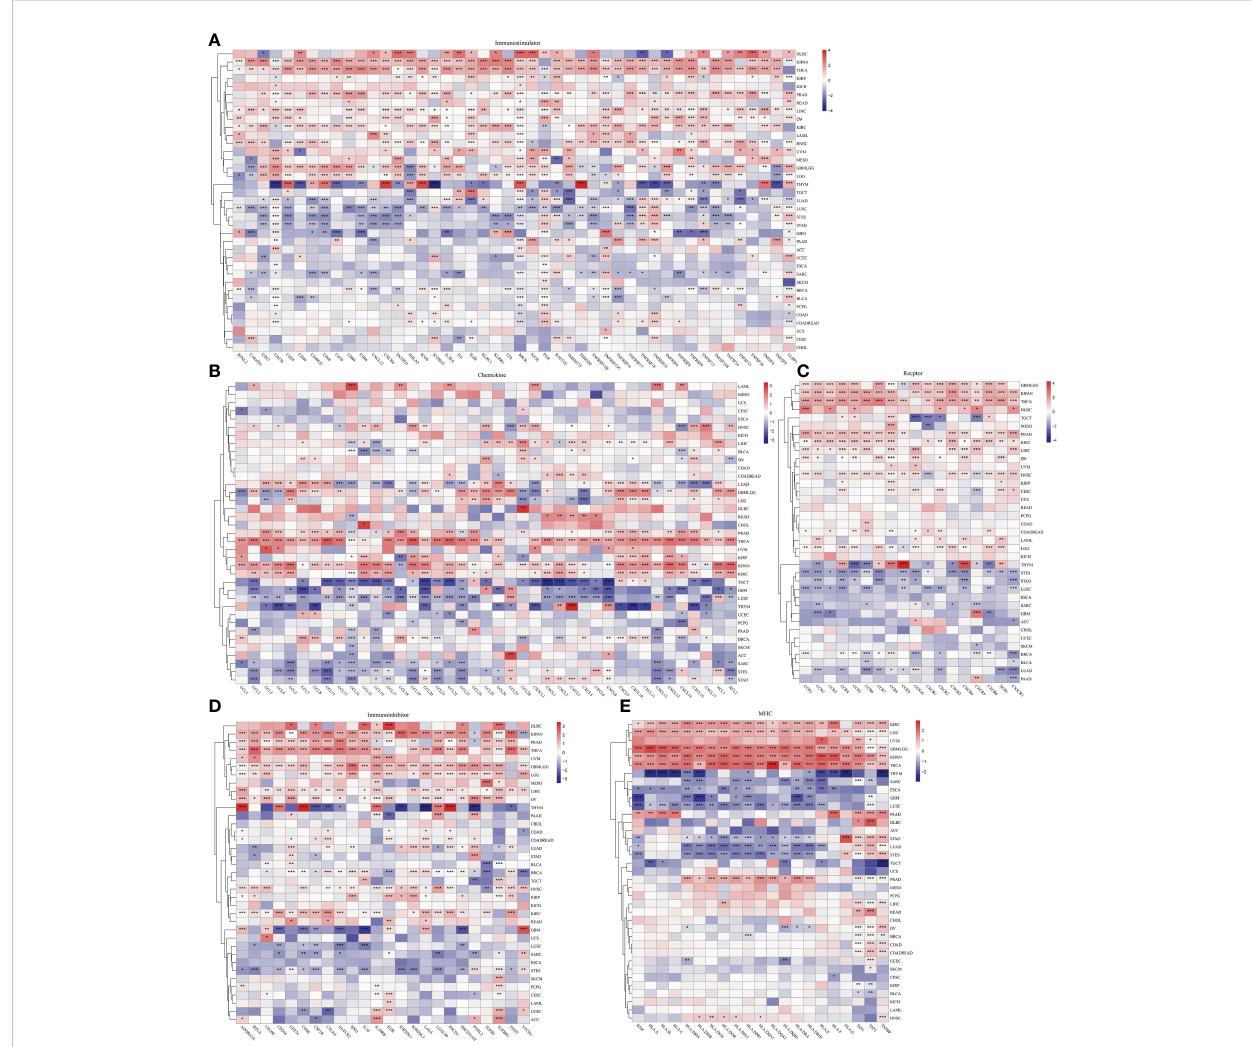
FIGURE 5 The effect of ESPL1 on immunological genes in pan-cancers. Correlation between ESPL1 and (A) immunostimulators, (B) chemokines, (C) receptors, (D) Immunoinhibitor and (E) MHC. *p<0.05, **p<0.01,